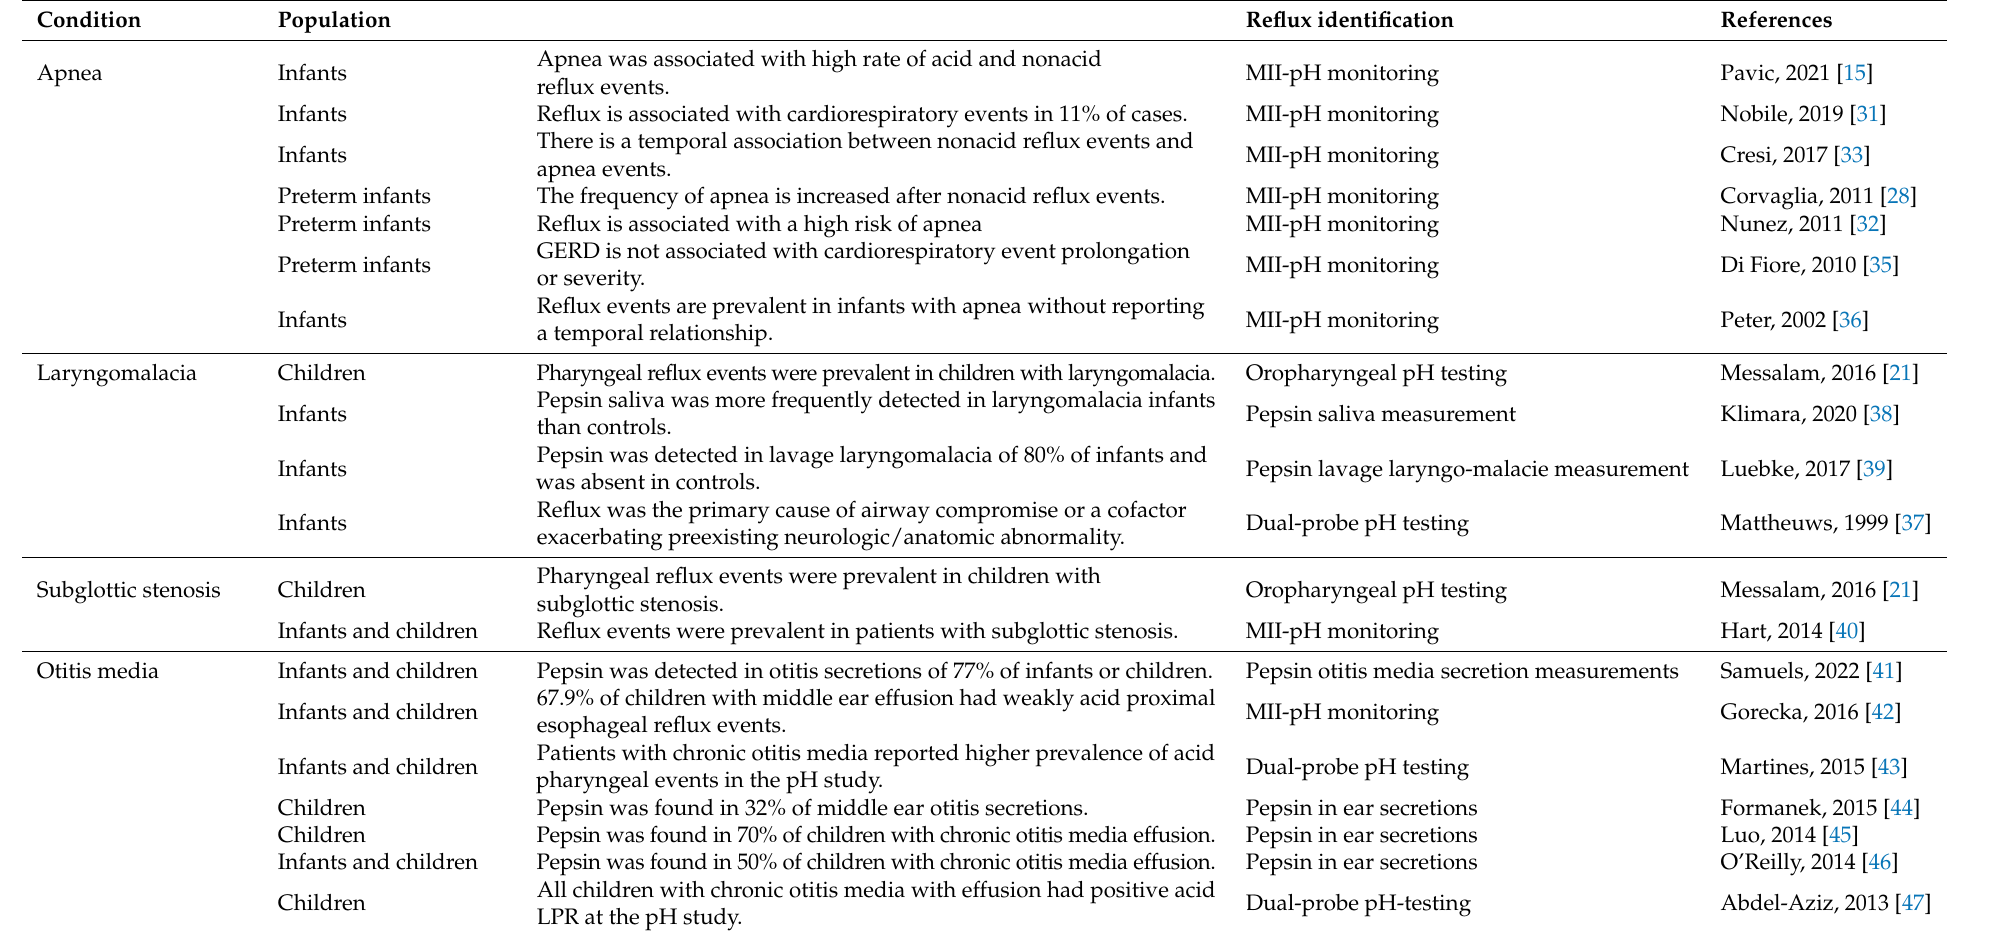
Table 1. Laryngopharyngeal reflux detection in ear, nose and throat